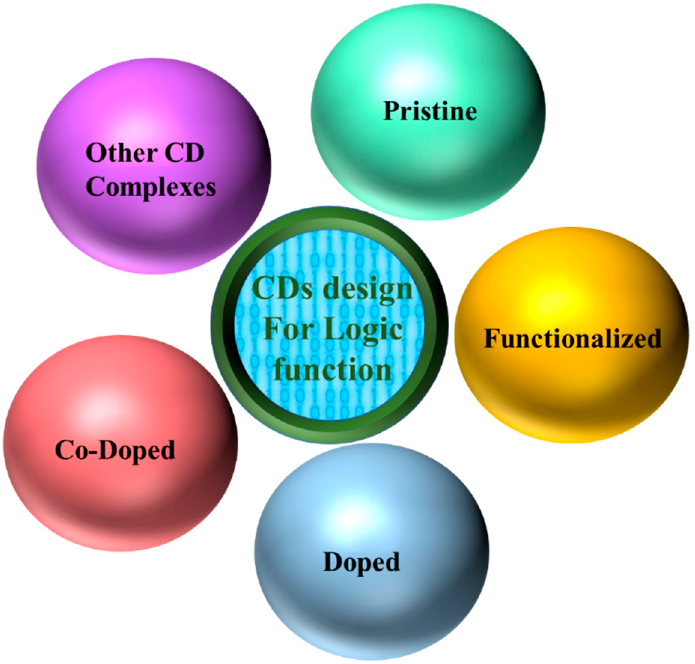
Figure 4. Five different categories of CDs design for logic function.